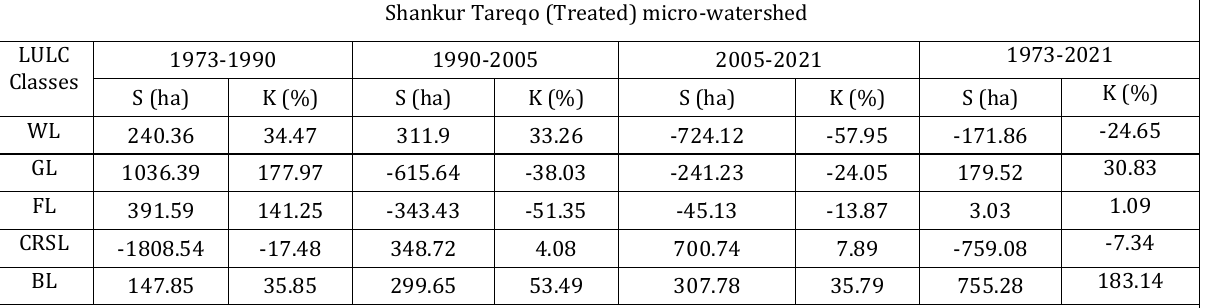
Table 2. Absolute variation in the area (S) and change rate (K) of LULC in the treated and untreated micro-watershed in different periods; increase (+) and decrease (-) Shankur Tareqo (Treated)